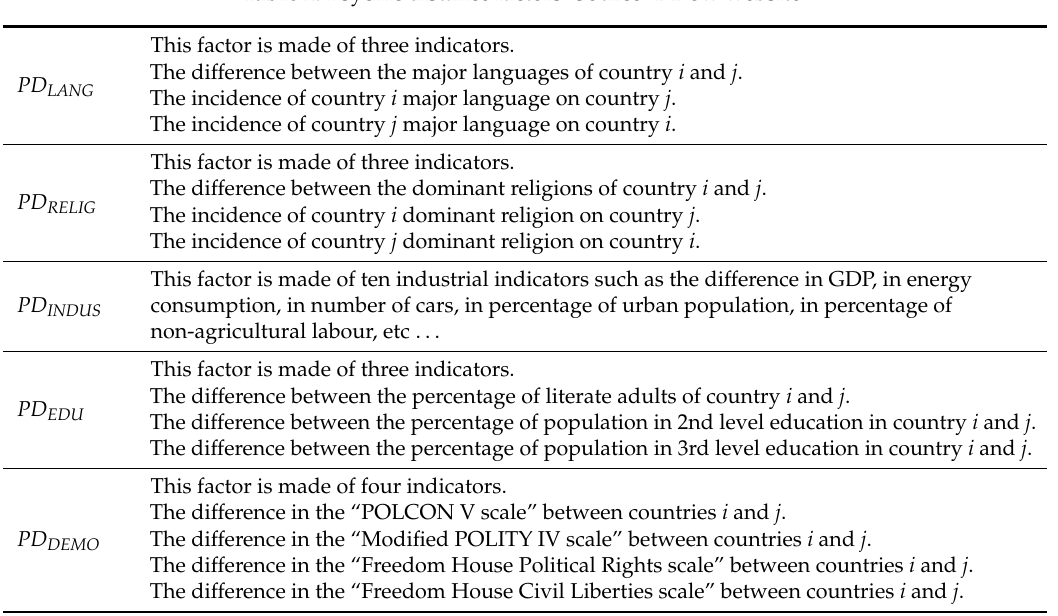
Table 2. Psychic distance factors. Source: DDow